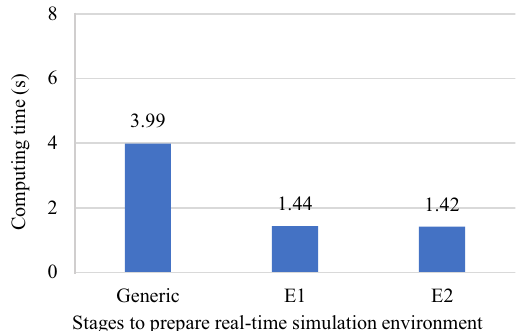
Fig. 14 Total computing time to execute the simulation of 1 s